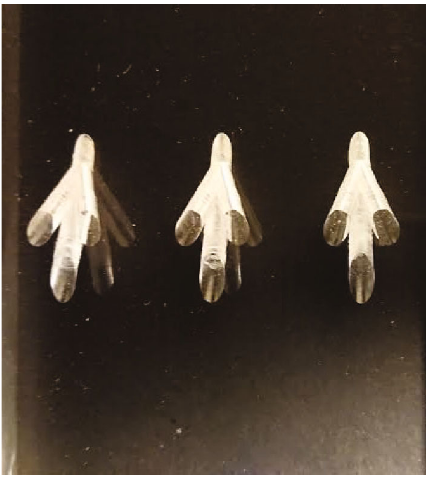
Figure 5: A typical CNC-machined test piece before testing.